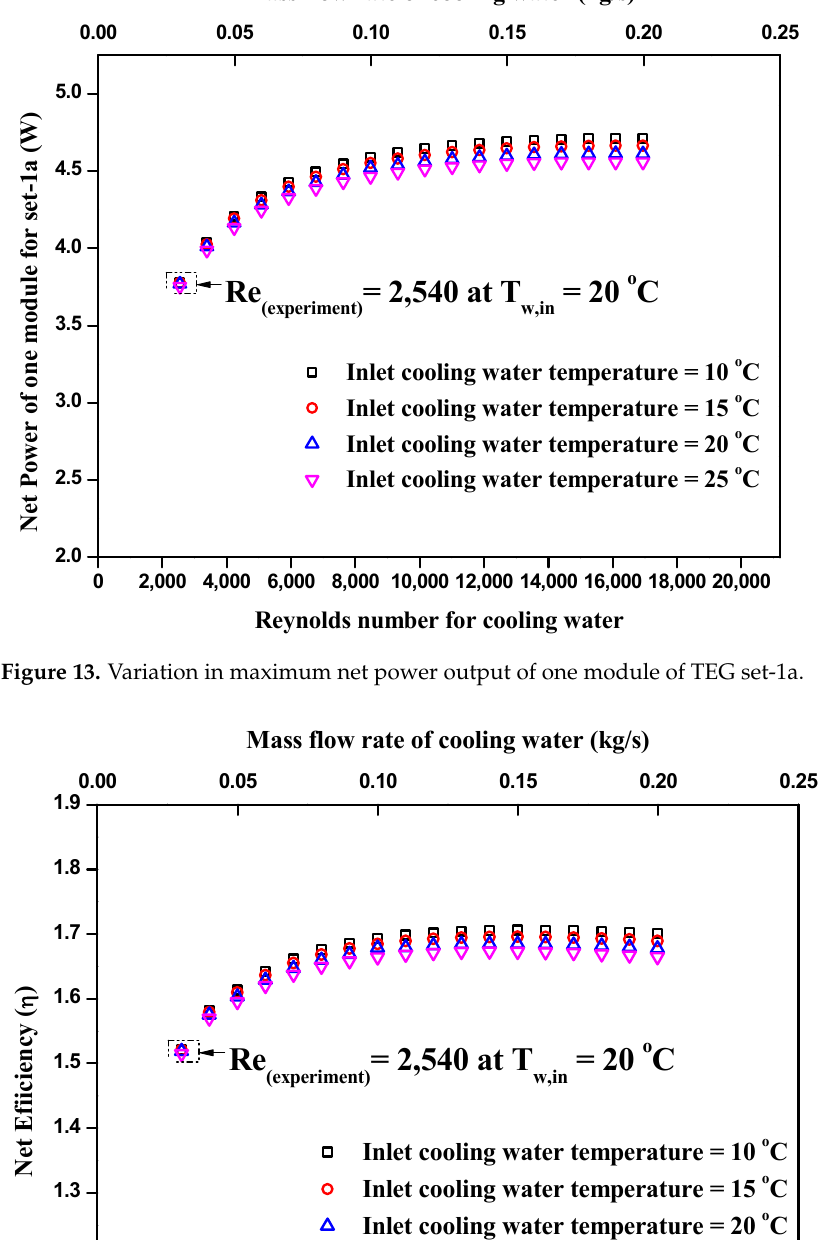
Figure 12. Variation in hot ‐ and cold ‐ side temperature difference.